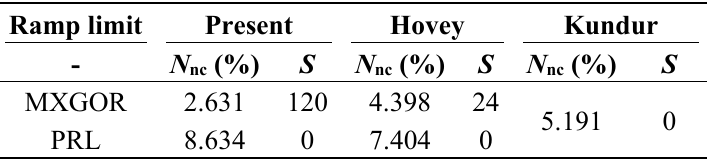
Table 3. Average percentage of cycles in which the power plant does not comply with the response